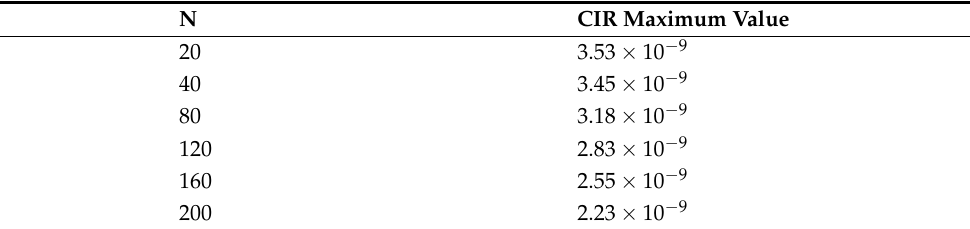
Figure 4. CIR of the scattering component with different values of N in the evaluated UM scenario. Table 2. Maximum CIR values for each value of